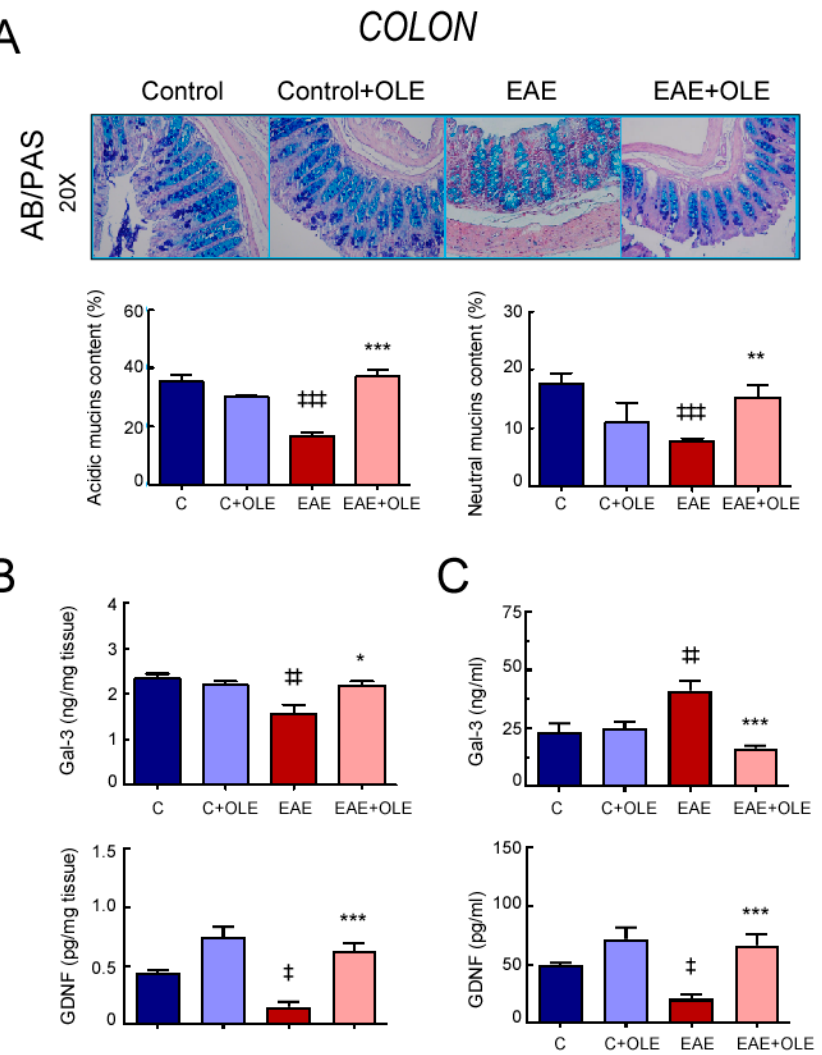
Figure 3. OLE treatment protects from intestinal mucin alteration in EAE mice. ( A ) Histological analysis of colon mucins stained with Alcian Blue/Periodic acid-Schiff (AB/PAS). Objective lens 10×. Representative photomicrographs and quantification graphs. Expression of galectin-3 (Gal-3) and glial cell line-derived neurotrophic factor (GDNF) in colon tissue ( B ) and in serum ( C ) were quantified by ELISA. Results were expressed as the mean ± SEM, n = 5–7 per group. ‡ p < 0.05, ‡‡ p < 0.01 and ‡‡‡ p < 0.001 vs. control; and * p < 0.05, ** p < 0.01 and *** p < 0.001, vs. untreated-EAE. C, healthy mice. C + OLE, healthy mice treated with OLE. EAE, induced mice. EAE + OLE, induced-mice treated with